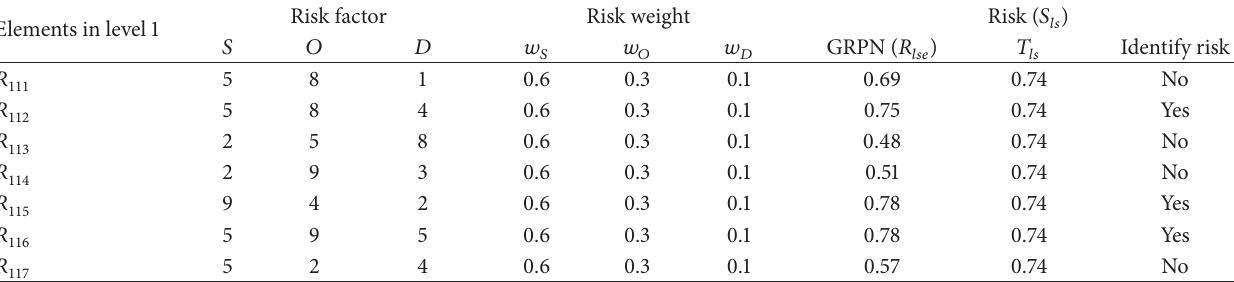
Table 13: Adaptive risk identification with scenario of risk weight threshold: